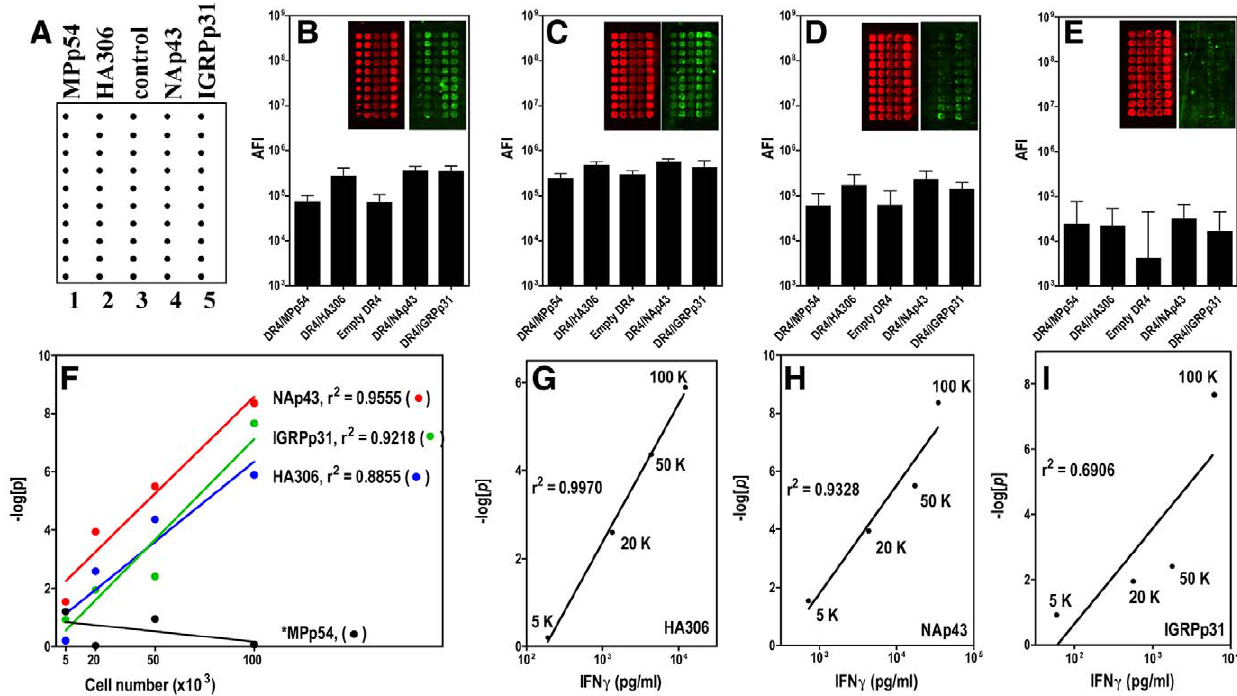
Figure 3. Correlation between microarray results and Ag-specific T cell inputs. A guide to print one 10 6 5 cellular microarray in one subunit of a 4-chamber slide (A). Raw fluorescence images and measured Absolute Fluorescence Intensity (AFI) of an array chamber loaded with 100 6 10 3 (B), 50 6 10 3 (C), 20 6 10 3 (D) and 5 6 10 3 (E) of Ag-specific HA306, NAp43 and IGRPp31-specific CD4 T cells. No MPp54-specific T cells were loaded for assaying. Green fluorescence images on the right of each panel represent Ag-specific cytokine production signals probed by AlexFluor555- conjugated streptavidin while red fluorescence images on the left of each panel represent non-specific signals probed by Cy5-conjugated anti-Rat IgG to facilitate the spot identification. Band-pass filters avoided spectral overlap. Only the green fluorescence was measured as AFI and proceeded for quantification. Correlations between ‘‘ 2 log[ p ] ’’ and corresponding numbers of HA306, NAp43 and IGRPp31 specific CD4 T cells are shown in panel (F). MPp54 data in (F) represents Ag non-specific signals revealed by corresponding chip assays. Correlations between ‘‘ 2 log[ p ] ’’ and IFNgamma production for HA306 (G), NAp43 (H) and IGRPp31 (I) are also shown to determine the concordance between two different assays (microarray assay and ELISA).